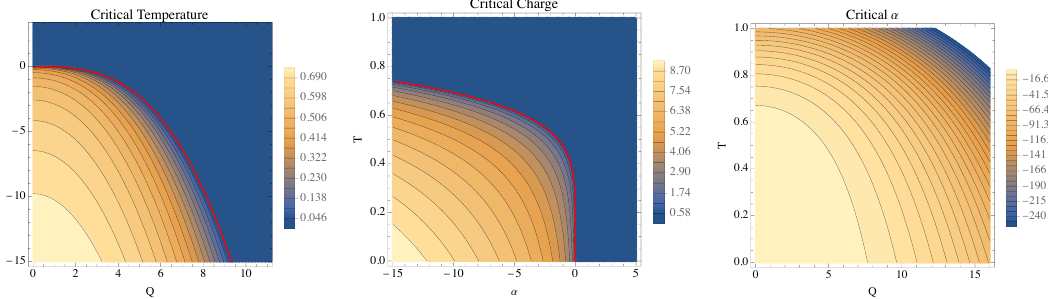
Figure 2 . From left to right are the contour plots of critical temperature, critical Q and critical α